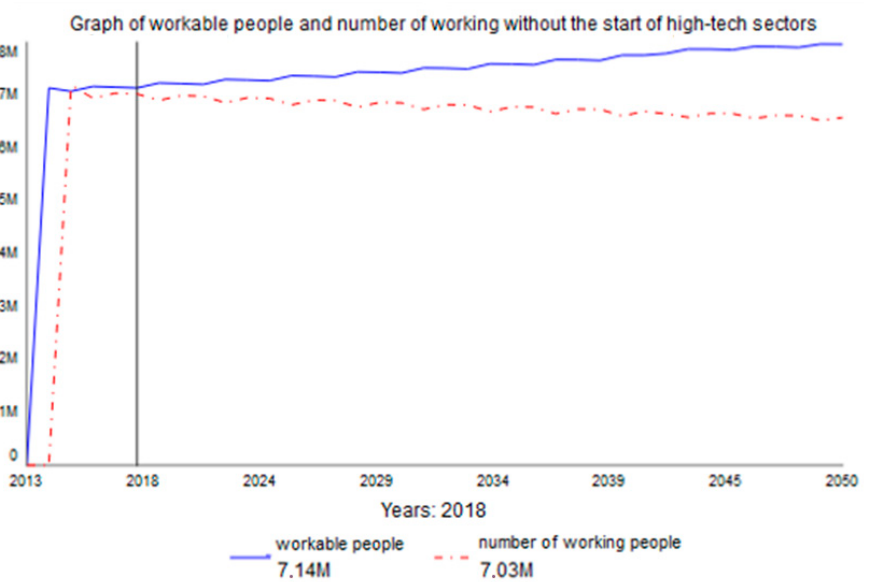
Figure 4. Economically active people and the number of working without the start of high-tech sectors (year 2018).